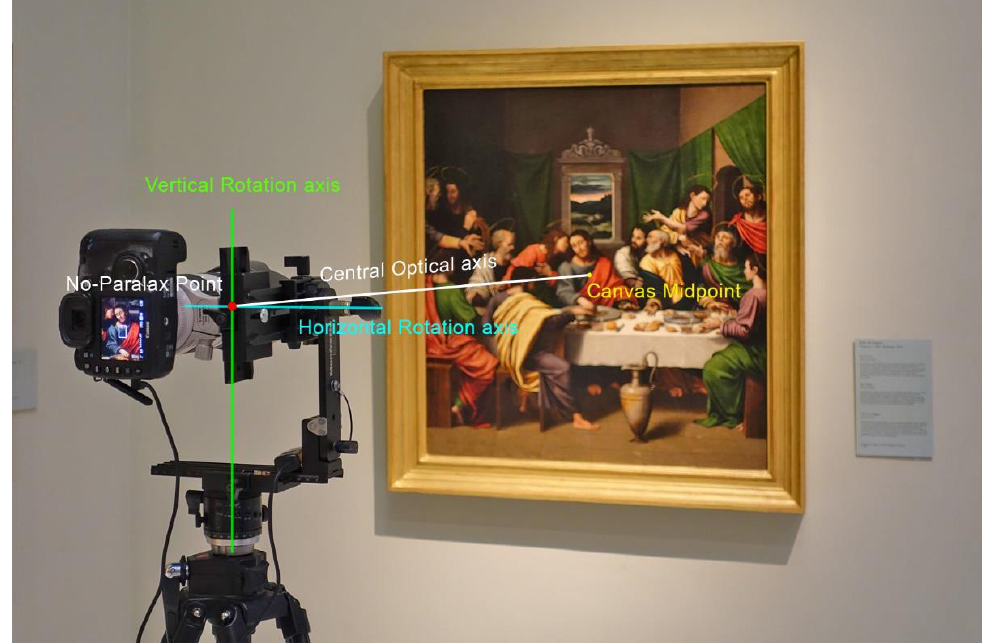
Figure 12. Single-viewpoint capture technique. Viewpoint position in the capture of the Santa Cena by Juan de Juanes (1534). Museo de Bellas Artes de Valencia (Spain).